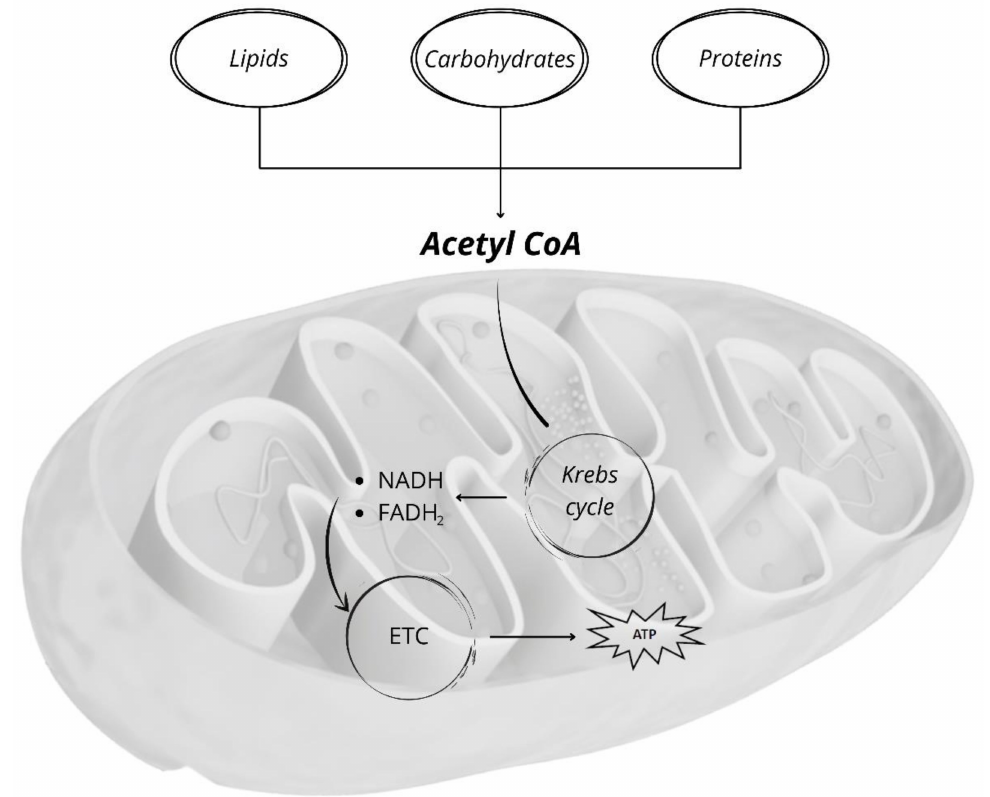
Figure 1. Schematic representation of the mitochondrial involvement in the catabolism of lipids carbohy- drates and proteins and ATP production. ETC: electron transport chain. ATP: adenosine